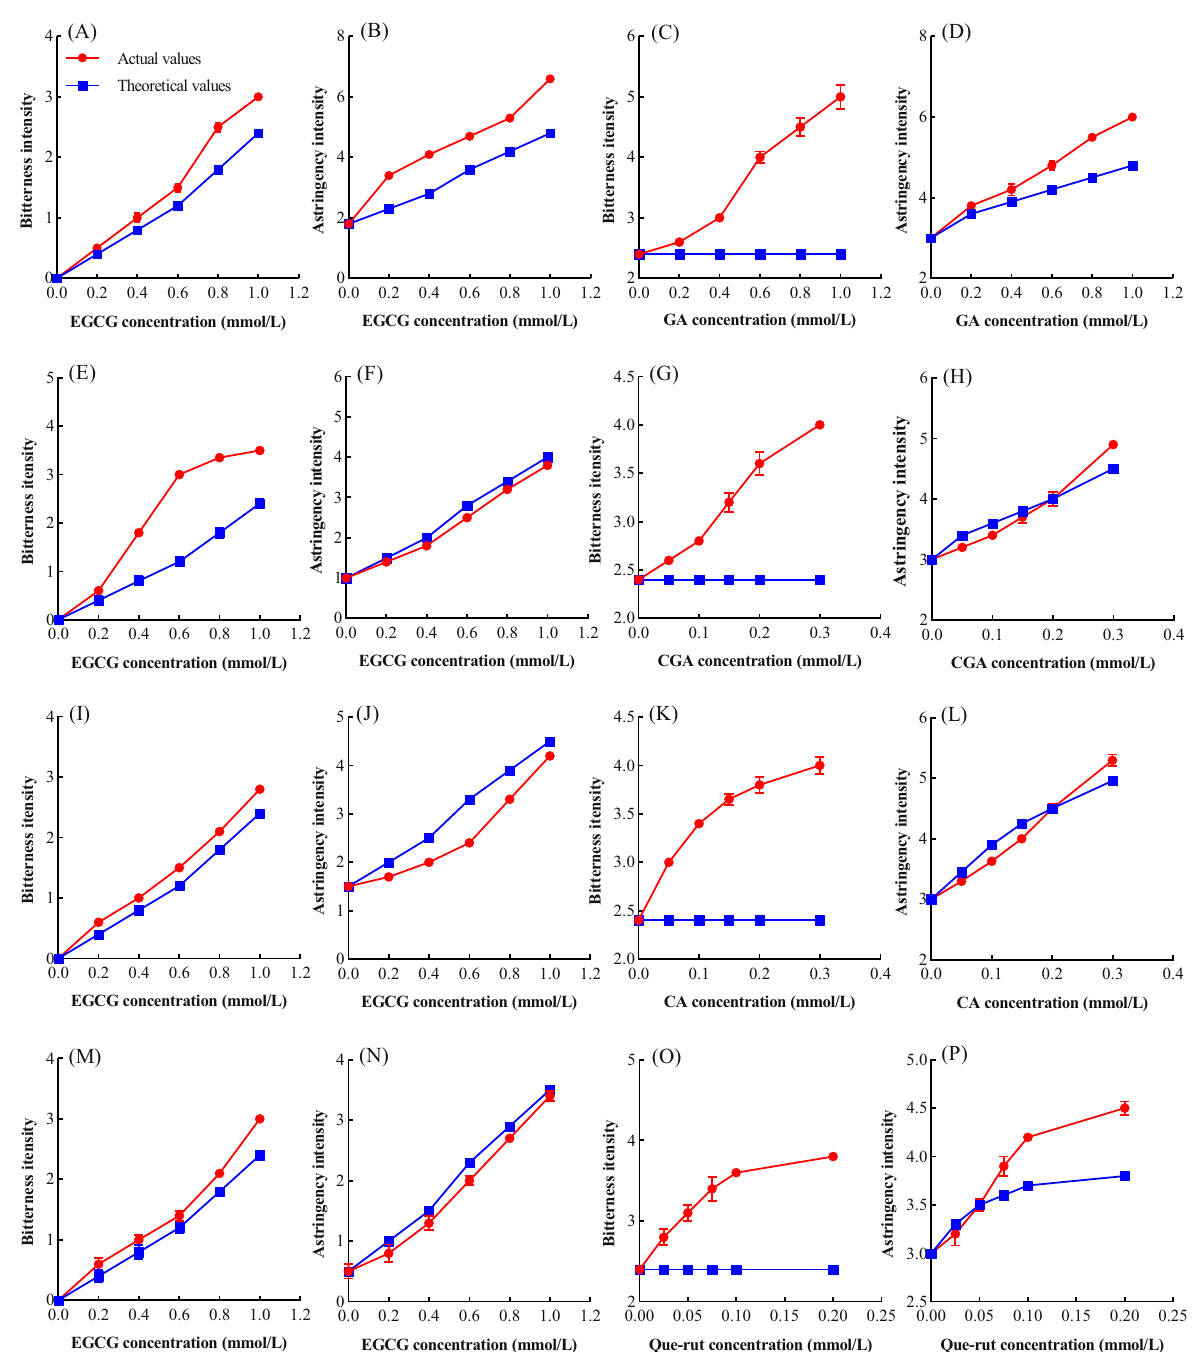
Fig. 2 Taste interactions between EGCG, and typical phenolic acids and Que-rut. Bitter and astringent taste interactions of EGCG at different concentrations with GA ( A , B ), CGA ( E , F ), CA ( I , J ), Que-rut ( M , N ). Bitter and astringent taste interactions of GA ( C , D ), CGA ( G , H ), CA ( K , L ), Que-rut ( O , P ) at different concentrations with EGCG. Actual values represent mixed system sensory scores between the different concentrations of EGCG and GA, CGA, CA, and Que-rut. Theoretical values represent the sum of the bitter and astringent taste points of each concentration of EGCG and the theoretical bitter and astringent taste of GA, CGA, CA, and Que-rut.